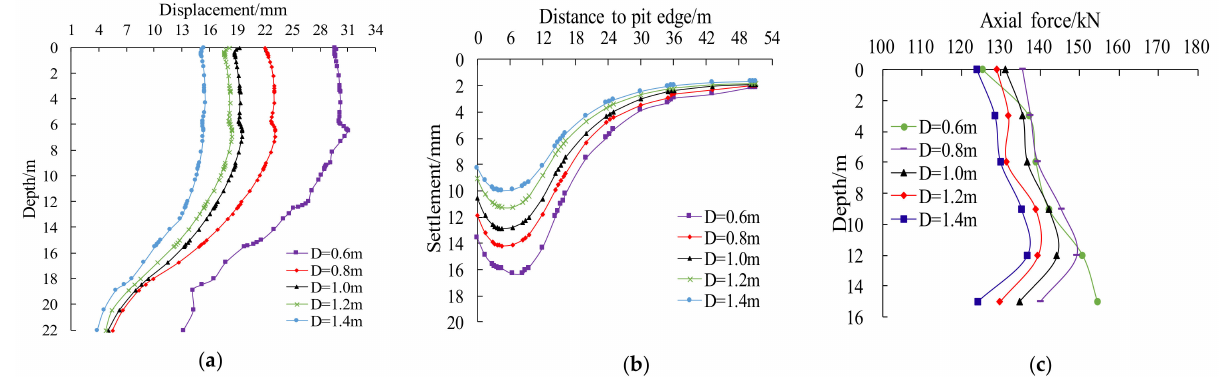
Figure 23. Influence curves of different pile diameters: ( a ) Horizontal displacement of piles, ( b ) Ground settlement, ( c ) Axial force.